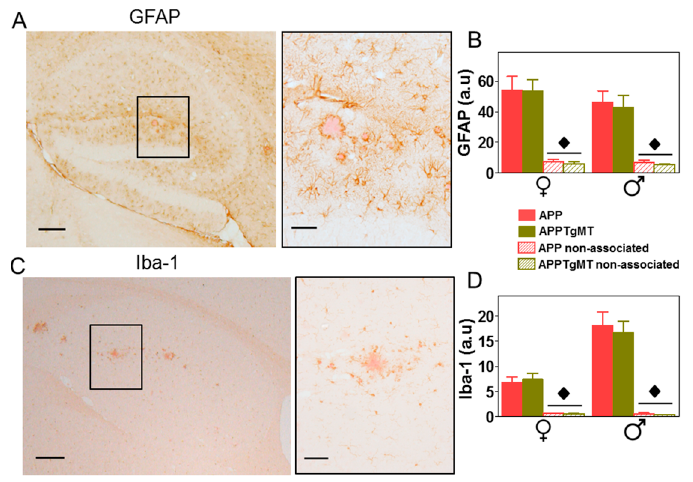
Figure 3. Effect of Mt1 overexpression on gliosis in the hippocampus. ( A , C ) Representative immunostaining for GFAP (astrocytes) and Iba-1 (microglia), respectively, counterstained with Congo Red, in the hippocampus of APPTgMT mice ( left ); scale bar: 200 µ m. On the right, a higher magnification of the black lined square area from left panel shows astroglia and microglia surrounding dense plaques; scale bar: 50 µ m; ( B , D ) Quantification of GFAP and Iba-1 IHC indicated a dramatic increase in the vicinity of the plaques. Results are mean ± SEM ( n = 11–18); (cid:117) p < 0.001 vs. plaque-associated staining. a.u., arbitrary units.